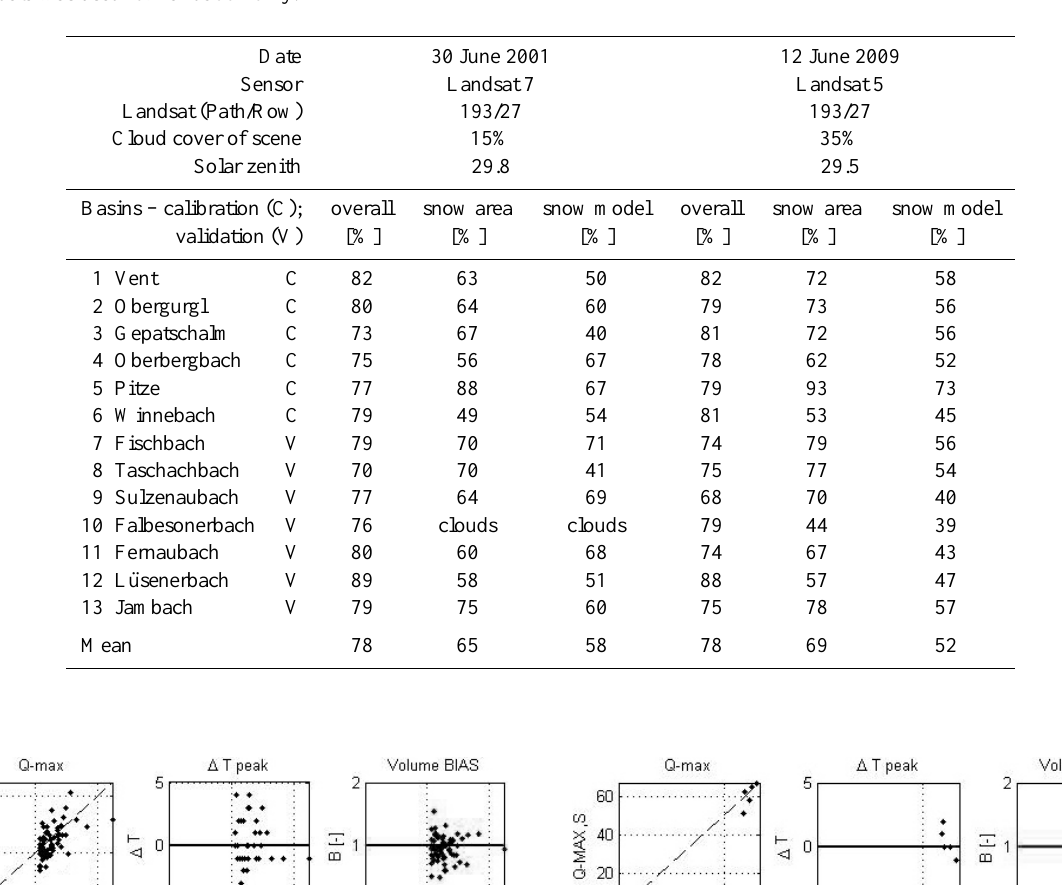
Table 4. Calculated overall agreements for all SES-catchments on 30 June 2001 and 12 June 2009; snow area or snow model is the catchments snow cover rate either assessed from the satellite image or calculated using SES. The 2001 data sets were used for calibration and validation, the 2009 data was used for validation only.